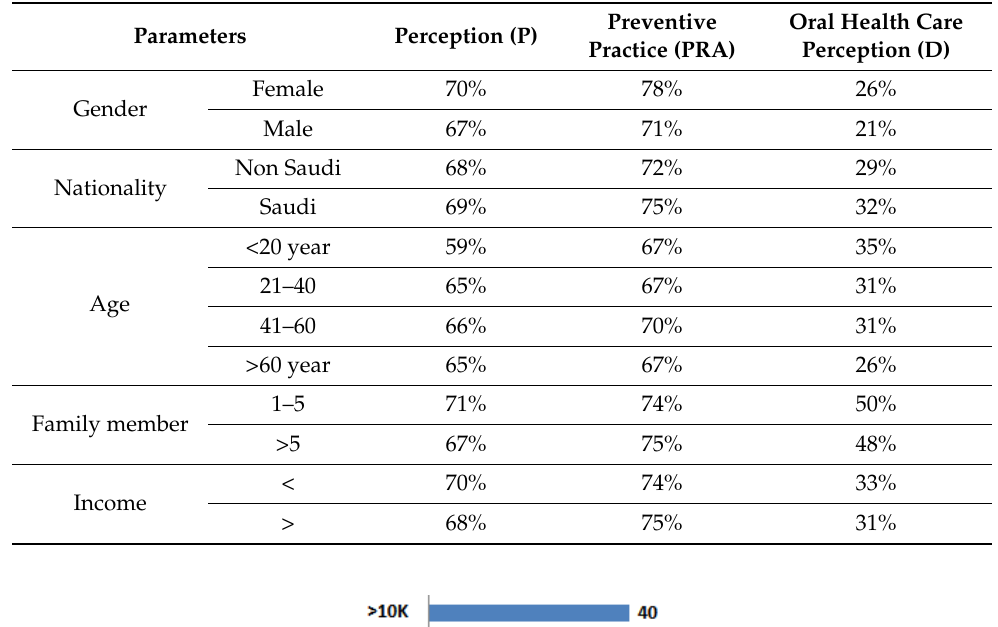
Table 2. Overall mean percentage scores of perception, preventive practice, and oral health care perceptions.